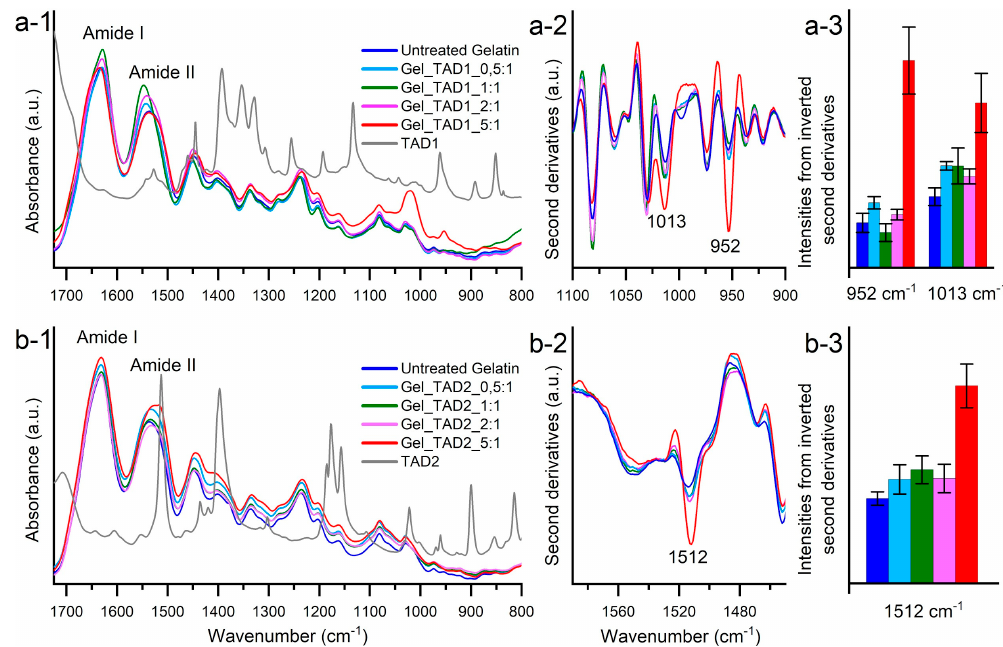
Figure 5. Insets a - 1 and b - 1 : ATR-FTIR absorption spectra of untreated gelatin, TADs and cross-linked gelatin specimens reported in the 1725–800 cm − 1 region.; the second derivatives of TAD 1 (inset a - 2 ) and TAD 2 (inset b - 2 ) cross-linked samples are reported in the spectral regions where the contributions of the TADs moieties can be detected. The intensities of the indicated components were evaluated from the second derivative spectra (insets a - 3 and b - 3 ). Error bars refer to three independent measurements. Spectra are shown after normalization at the Amide I band area.